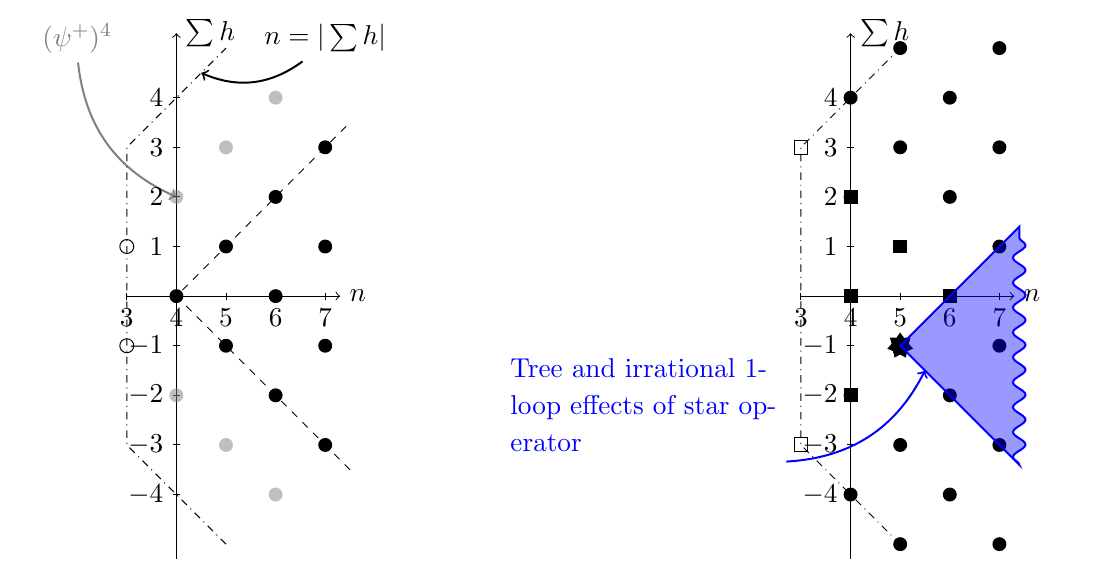
Figure 4 . Dimension 4 (left) and dimension 6 (right) amplitudes. Squares denote possible contact insertions of operators. The starred contact insertion at (5 ; (cid:0) 1) may only contribute to tree-level and cut constructible one-loop level (barring exceptional amplitudes) processes within the blue